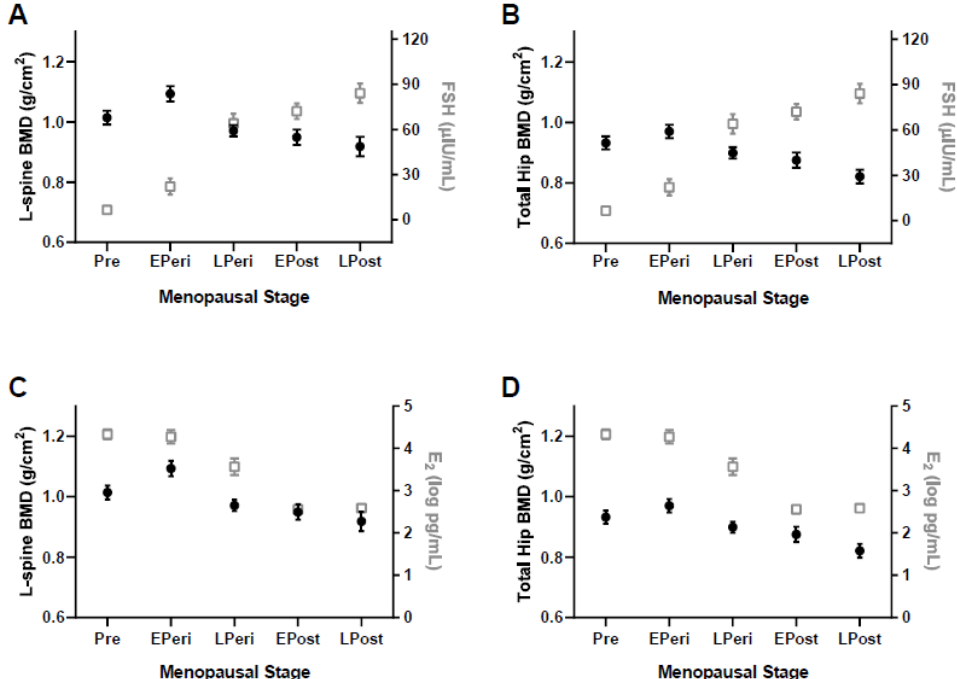
Figure 1. Bone mineral density (BMD) and sex hormones in different menopausal stages. ( A ) Lumbar-spine (L-spine) BMD versus follicle stimulating hormone (FSH), ( B ) total hip BMD versus FSH, ( C ) lumbar-spine BMD versus estradiol (E 2 ), and ( D ) total hip BMD versus E 2 . Values are means ± SE. Solid symbols indicate BMD, open symbols indicate hormone levels. Pre = premenopausal; EPeri = early perimenopausal; LPeri = late perimenopausal; EPost = early postmenopausal; LPost = late postmenopausal.